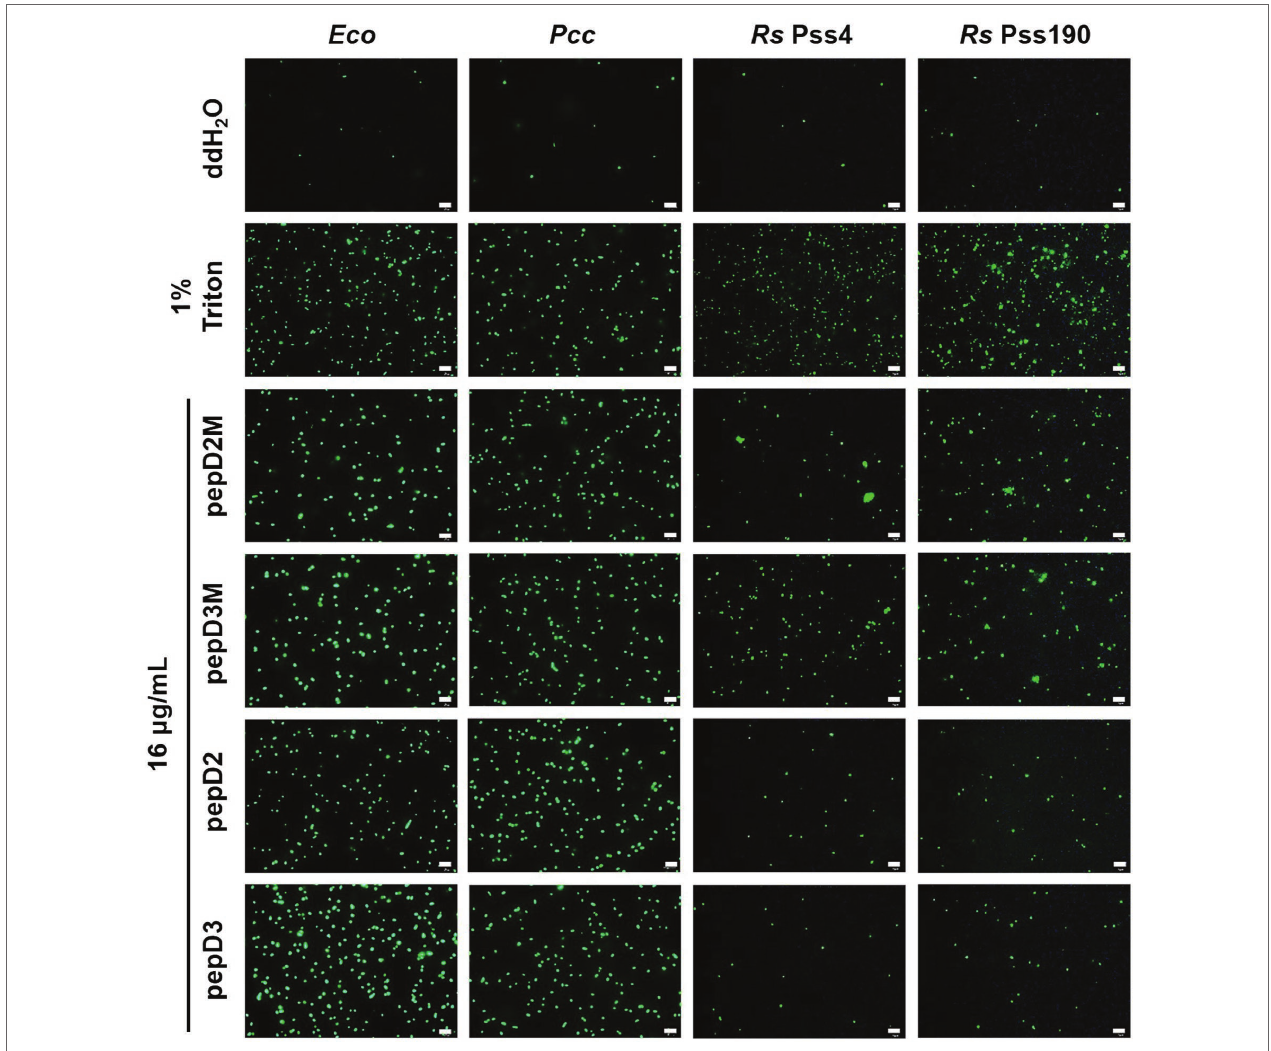
FIGURE 4 | Effect of the peptides on the membrane permeability of Escherichia coli and phytopathogenic bacteria. The membrane permeability was analyzed after the peptide treatments using SYTOX Green staining. The bacteria that were cultured in optimal rich media for 16–20 h were recovered and prepared as OD 600 = 0.4 in sterile water. Five microliters of the bacterial suspension was mixed with 10 μ l of SYTOX Green (2 μ M) and 5 μ l of the peptide (64 μ g/ml). Crude peptides that were not purified via high-performance liquid chromatography (HPLC) were used. The SYTOX-Green-stained cells were observed using confocal microscopy after they were incubated for 2 h in the dark. The data are from a single experiment that was repeated at least three times with similar results. Eco , E. coli ; Pcc , Pectobacterium carotovorum subsp. carotovorum ; and Rs , Ralstonia solanacearum . Bar = 20 μ m.